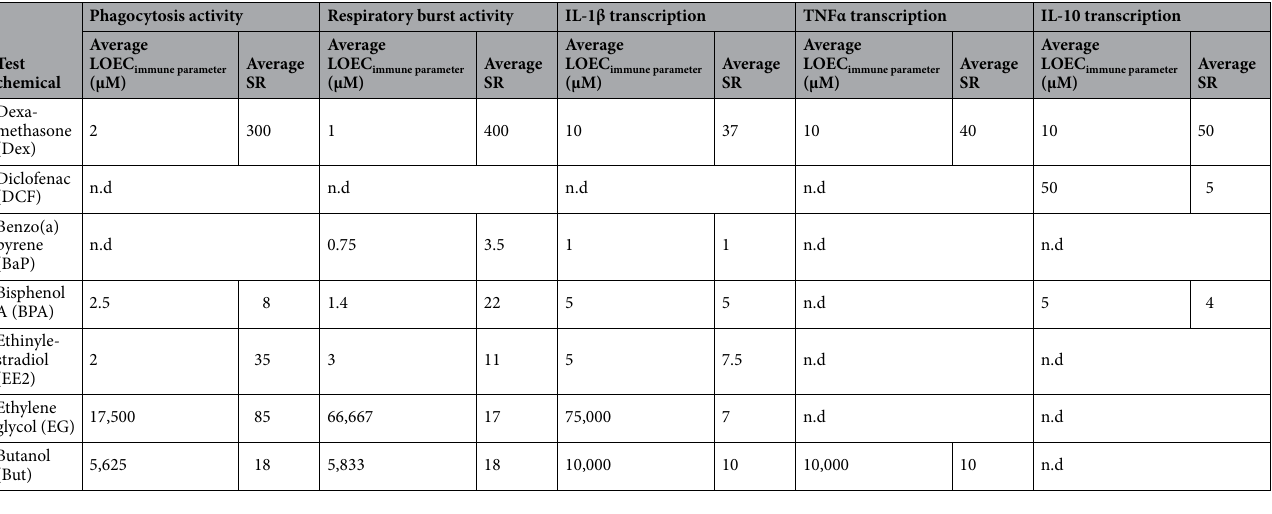
Table 4. Average LOEC immune parameter and average specific ratios (SR) for the immune parameters. The averages are derived from the values for short- and long-term exposure, each without and with LPS. n.d. not determinable, SR specific ratio, LOEC lowest observed effect